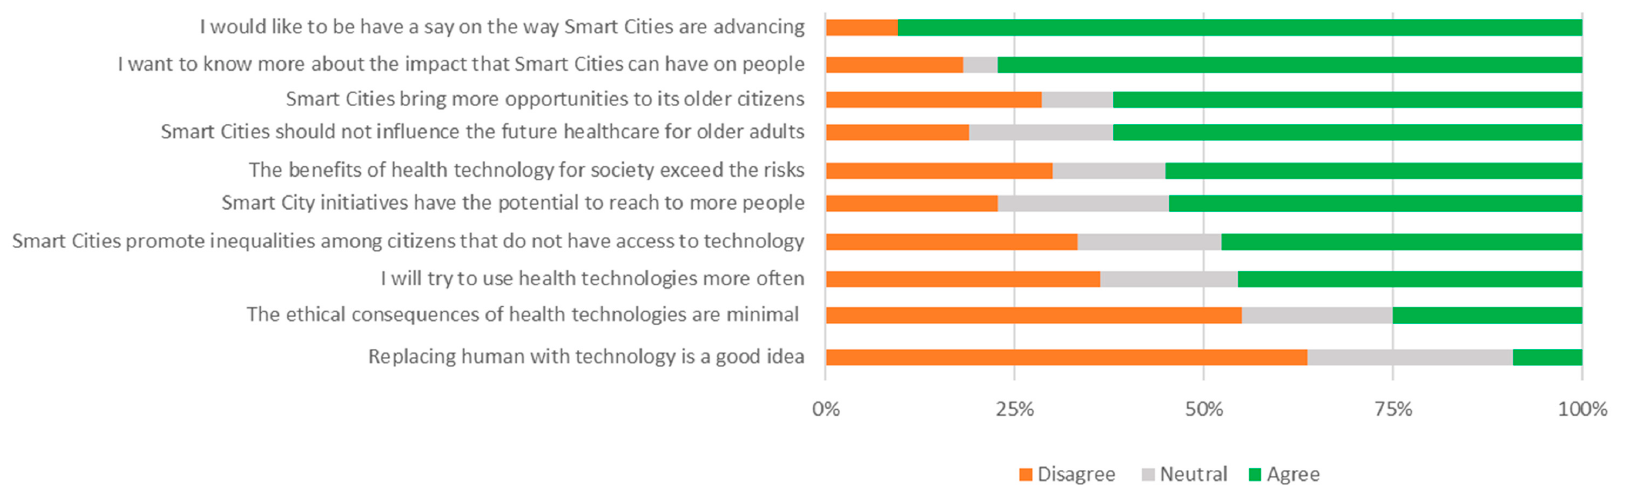
Figure 2. Post-session responses of all participants to the statements relating to issues raised in the juries. Differences between the groups were not significant for any of the statements.